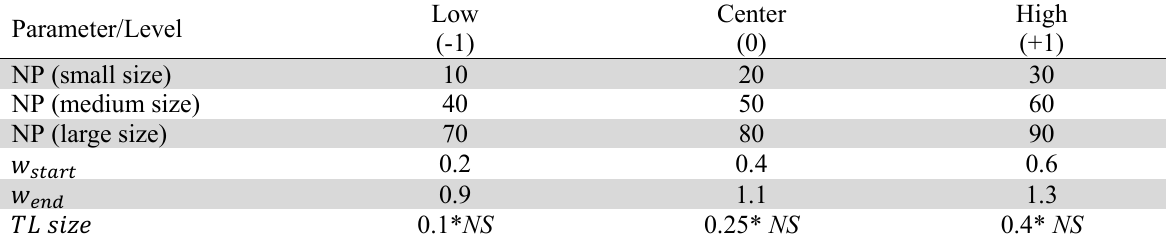
, PSO , and PSO (cid:2911) (cid:2912) (cid:2913)